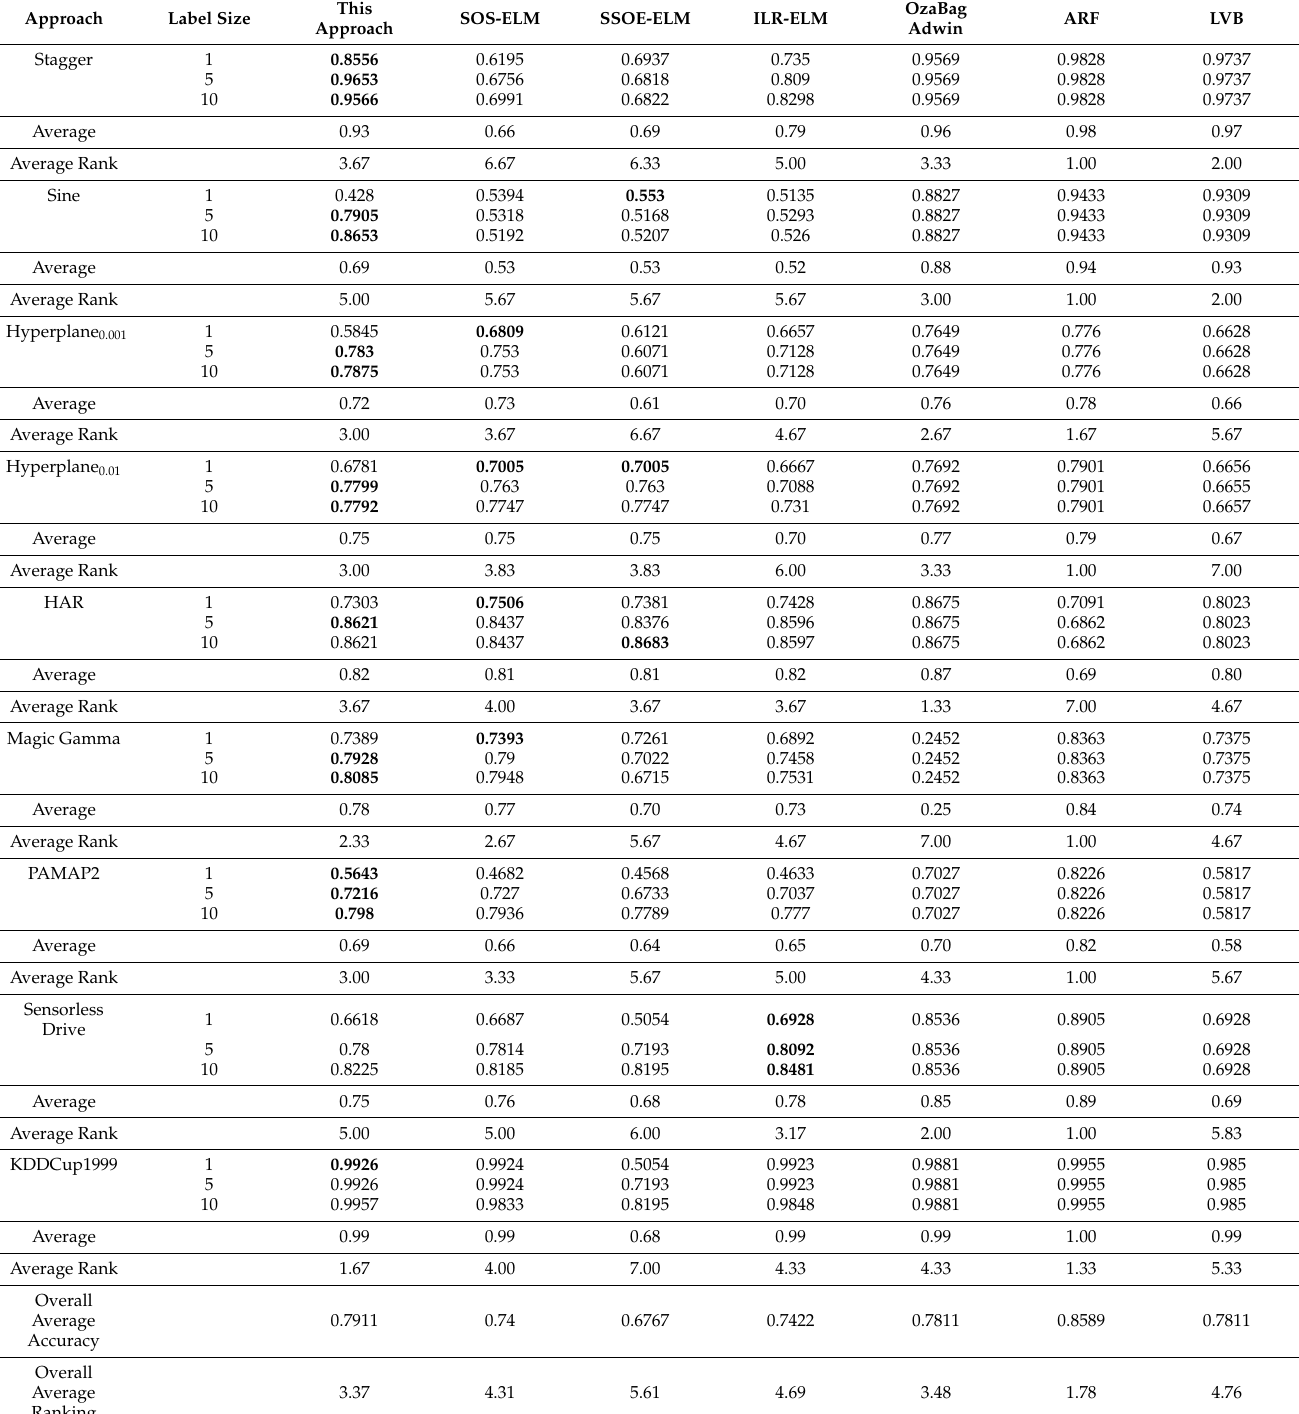
Table 5. Performance comparison of this approach compared with other related semisupervised learning techniques and adaptive supervised learning